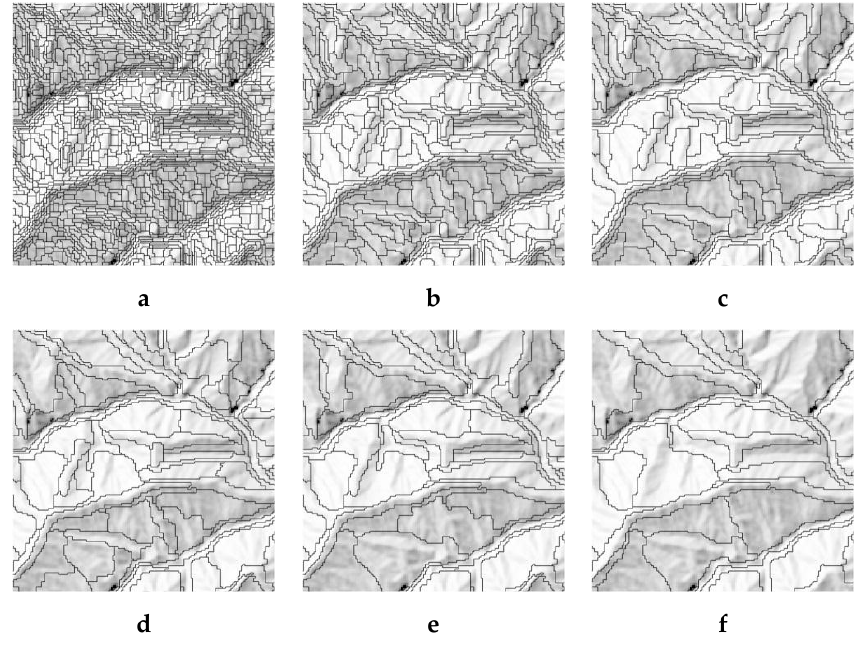
Figure 5. Segmentation at scales: ( a ) 2; ( b ) 5; ( c ) 8; ( d ) 11; ( e ) 14; ( f ) 17.